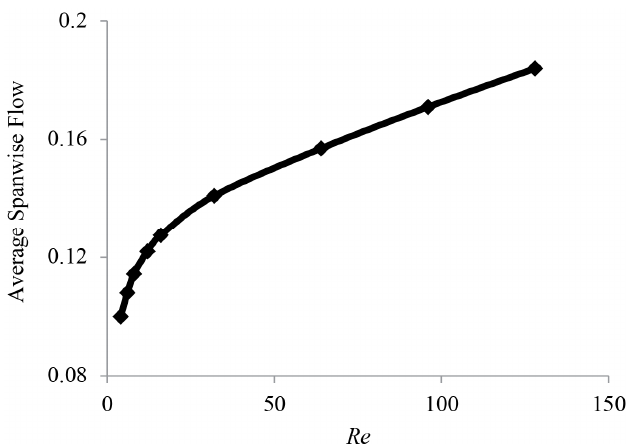
Figure 10. The spanwise flow velocity averaged along the dashed transect shown in Figure 8a as a function of Re (aoa = 45) obtained from three-dimensional computational simulations.